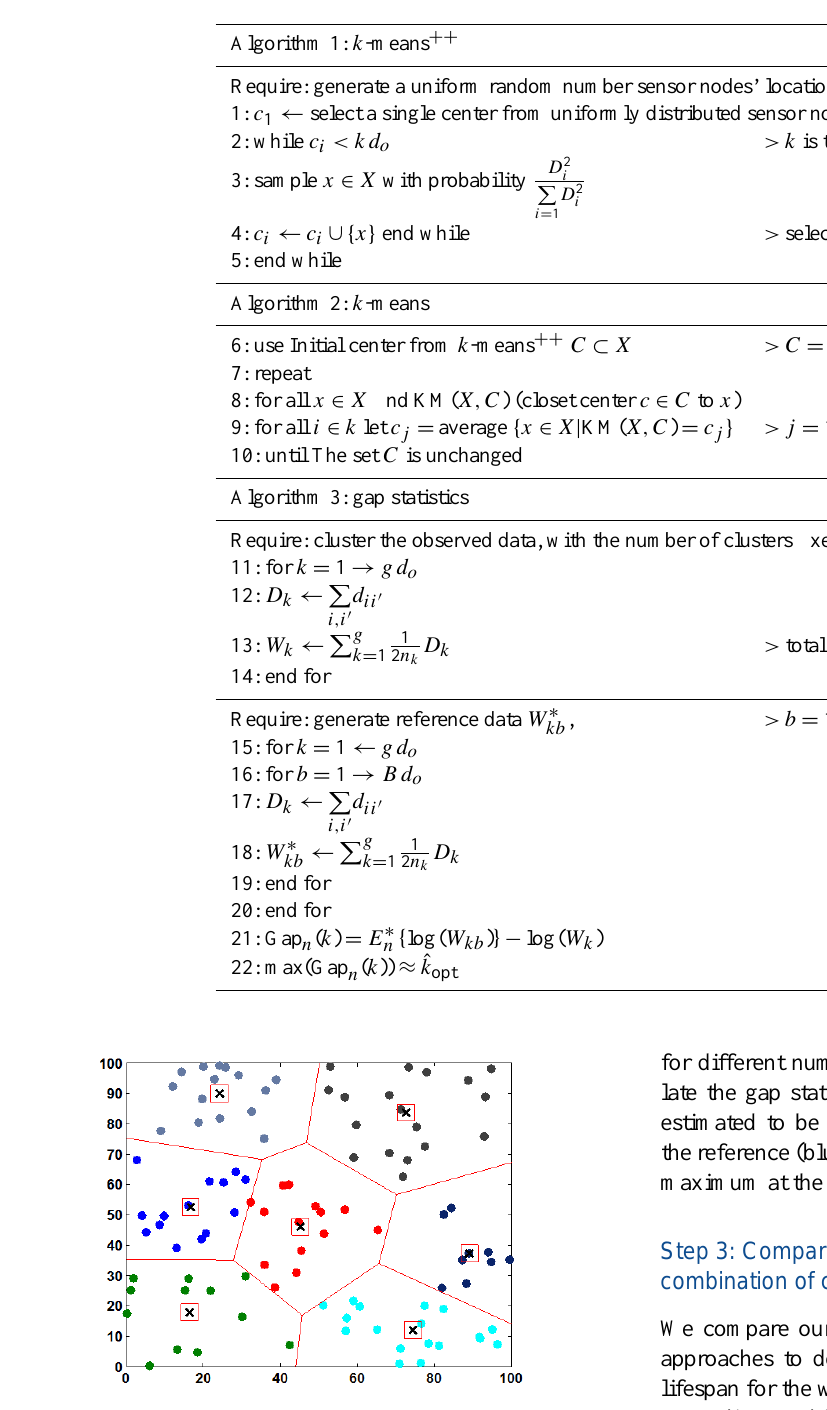
Figure 7. Sensor nodes grouped in seven clusters.